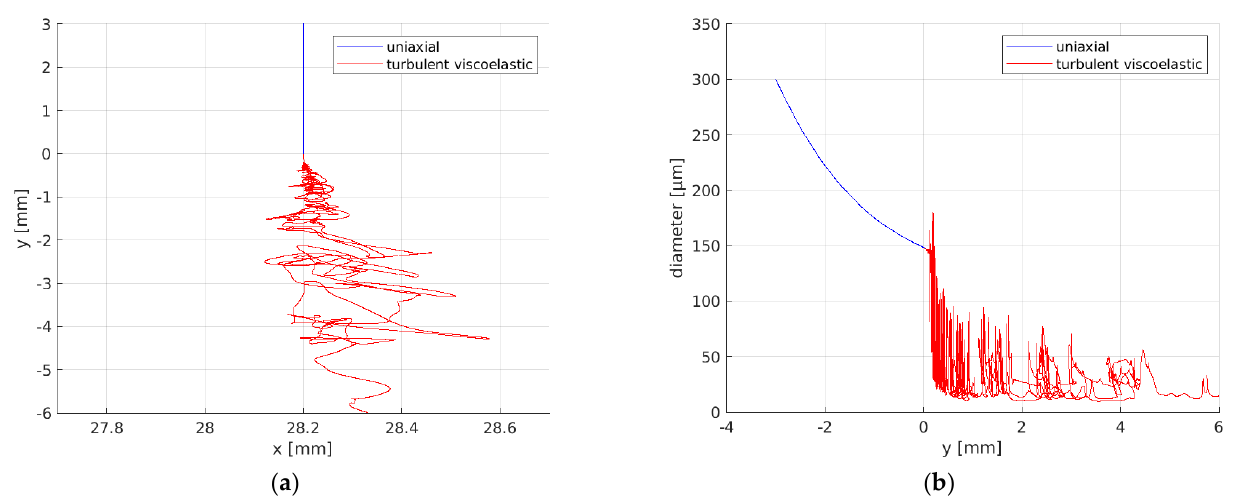
Figure 12. Uniaxial viscous (blue) and unsteady viscoelastic (red): ( a ) fiber deflection and ( b ) fiber diameter; simulated for a certain timestep.